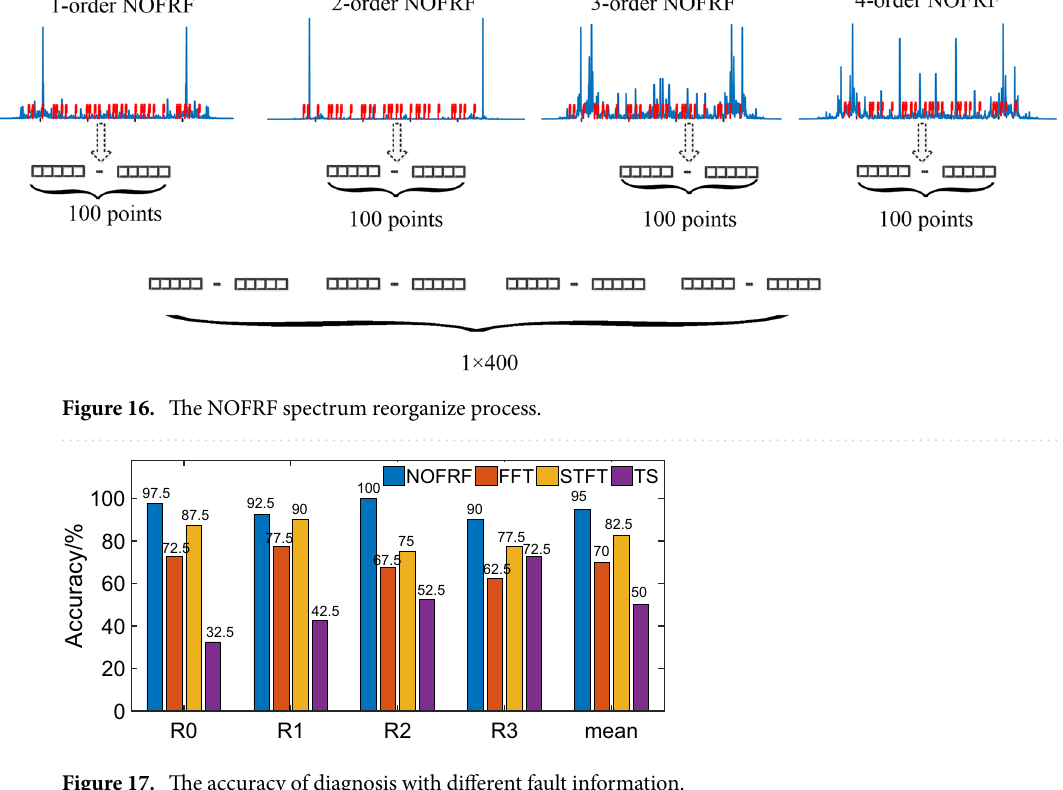
Figure 17. The accuracy of diagnosis with different fault information.